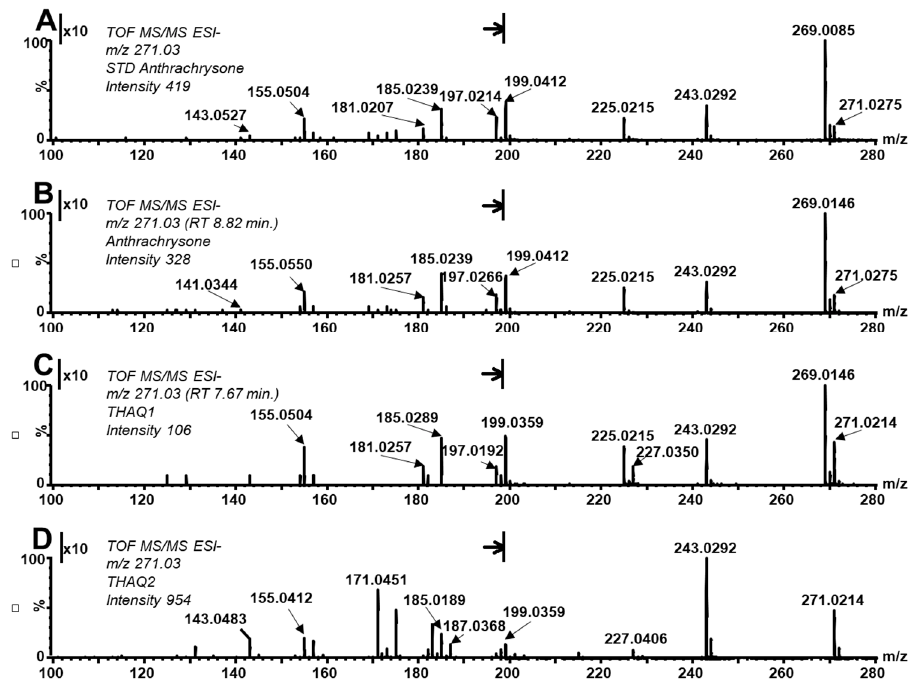
Figure 3. MS/MS spectra of ATCS standard ( A ), ATCS rising in a heated PGA solution ( B ), THAQ1 in the heated PGA solution ( C ), and THAQ2 ( D ). ( m / z range 100–197, denoted by vertical lines and an arrow to the right, was zoomed 10 times).